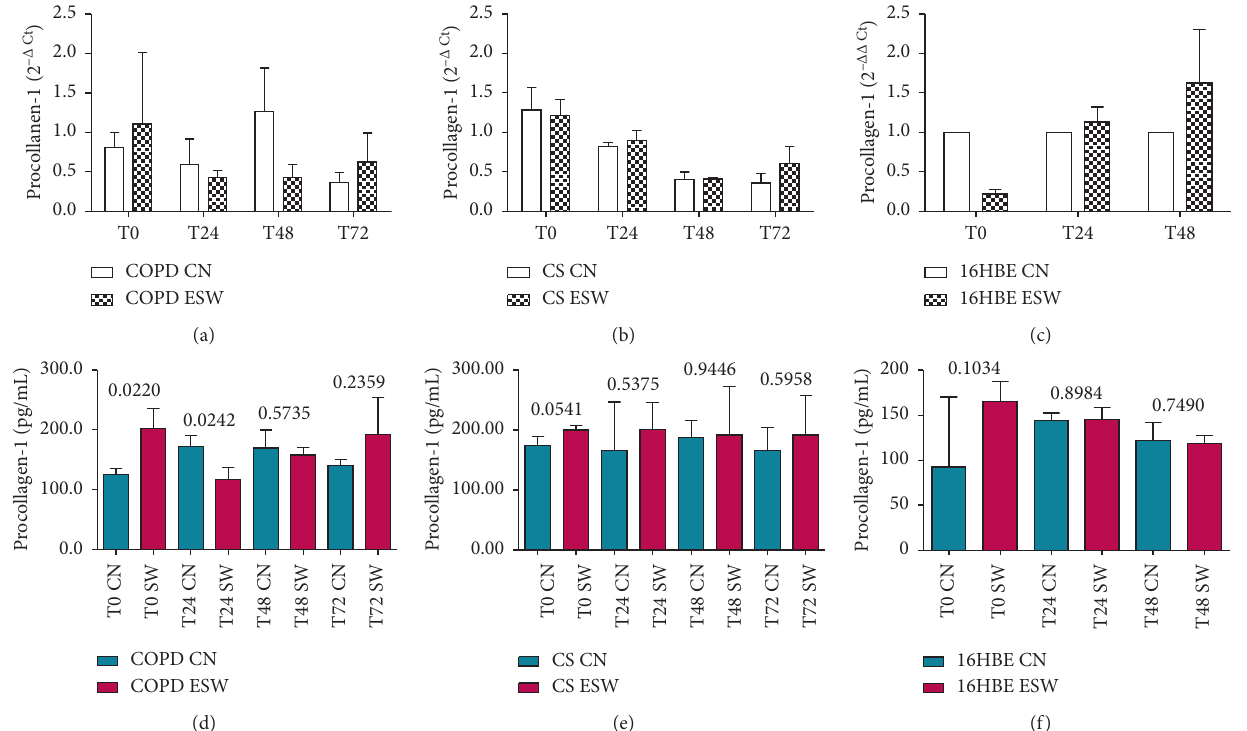
Figure 6: Procollagen-1 mRNA (a, b, c) and protein (d, e, f) expression after ESW treatment in primary bronchial fibroblasts of COPD patients (a, d), primary bronchial fibroblasts of control smokers (b, e), and bronchial epithelial cells (c, f). In primary bronchial fibroblasts of COPD patients, procollagen-1 increased at protein level ( d) at 4 h (T0), followed by a decrease at 24h (panel d). T -test was used for comparative purposes, and p values are reported in the